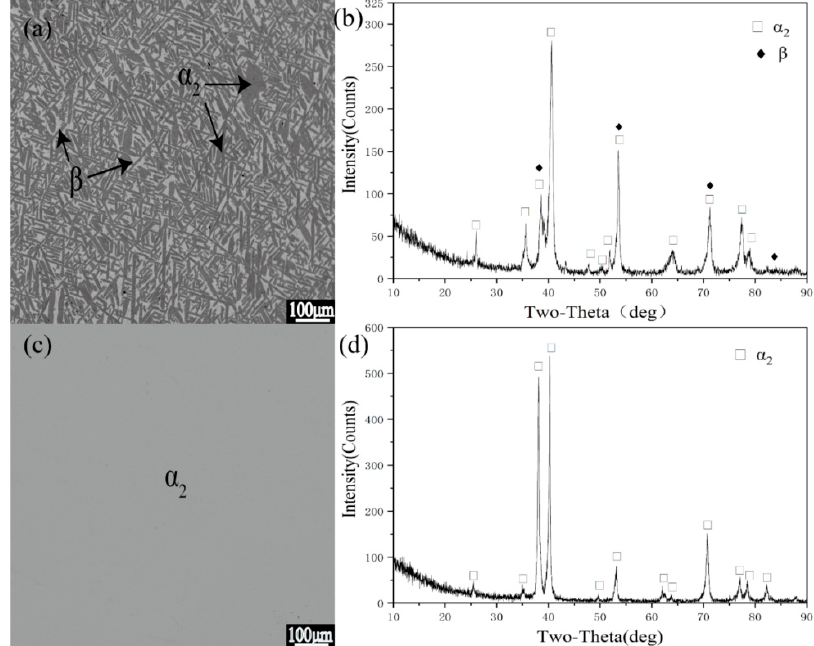
Figure 2. Electron probe micro-analysis (EPMA) images and XRD results of alloy #1 after annealing at 1000 °C, 900 °C. ( a ) The microstructure of alloy #1 at 1000 °C; ( b ) the XRD result of alloy #1 at 1000 °C. ( c ) The microstructure of alloy #1 at 900 °C; ( d ) the XRD result of alloy #1 at 900 °C. Alloy #4 was designed to confirm the transformation of the ternary β + α 2 + O phase